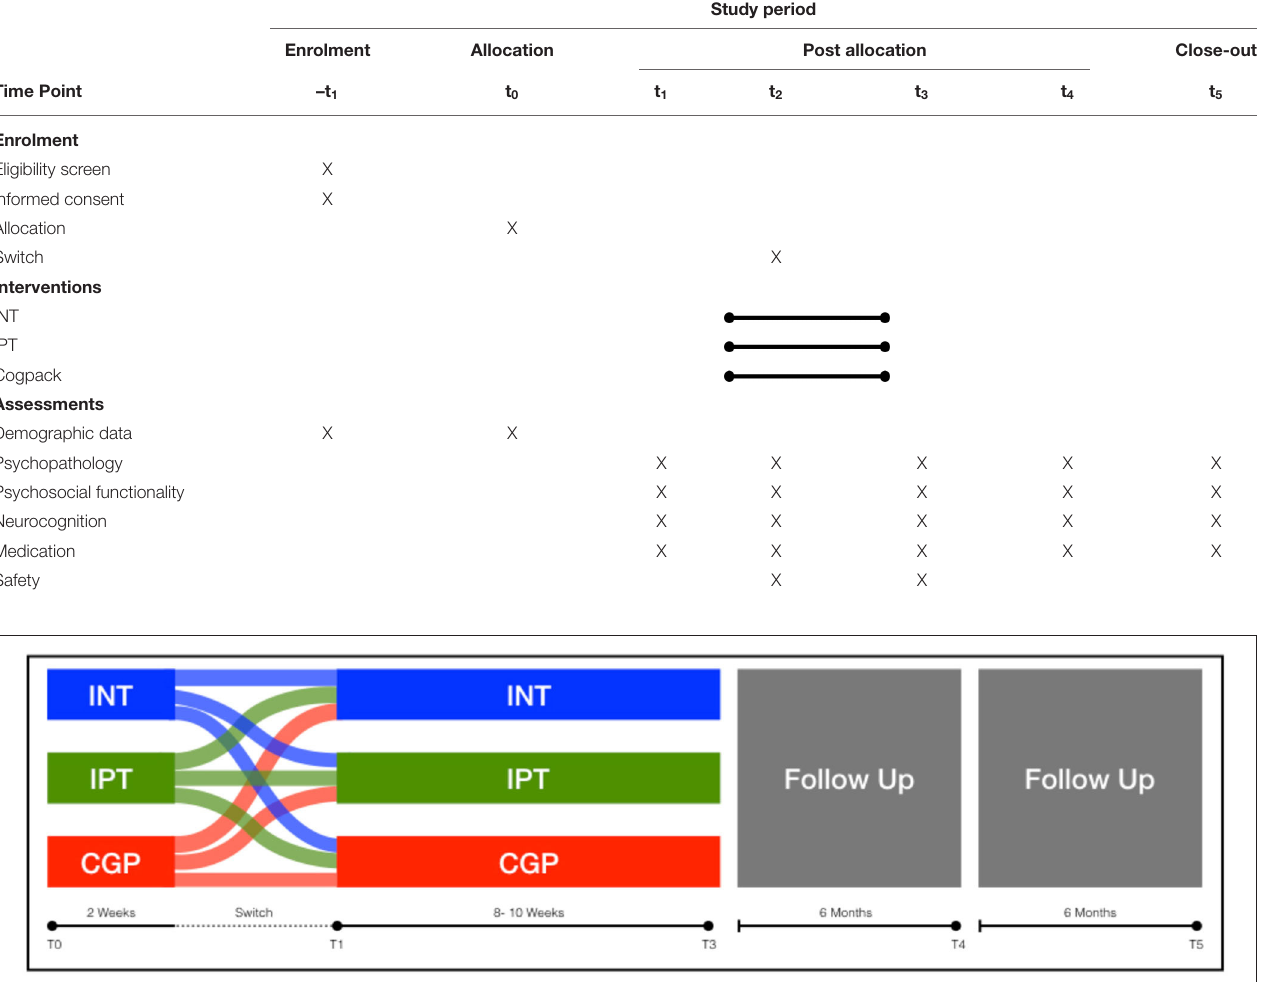
TABLE 3 | Schedule of enrolment, interventions, and assessments.